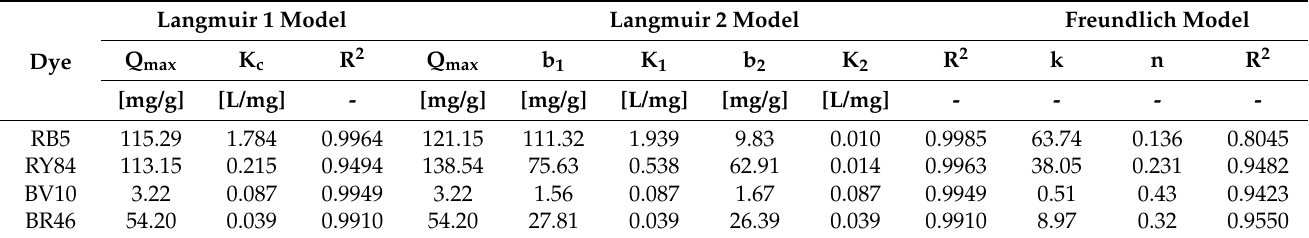
Table 4. Constants determined from Langmuir 1, Langmuir 2, and Freundlich